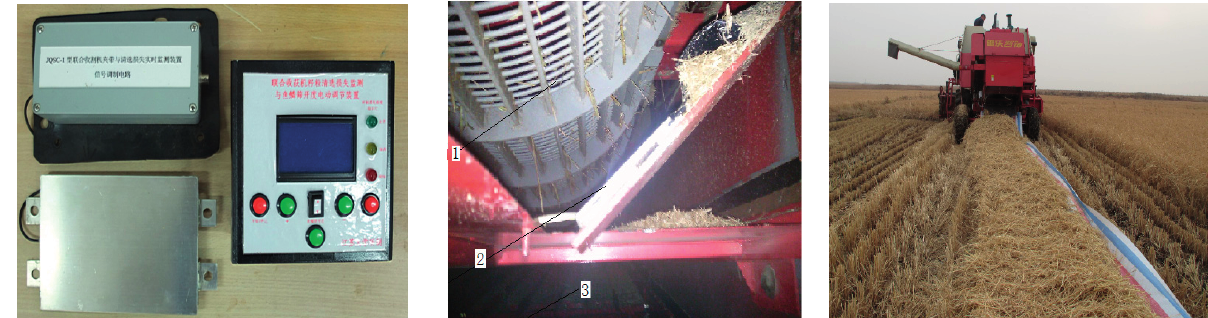
Figure 14. Installed position of the sensor on a combine harvester and experiments. 1. Separation concave; 2. Monitoring sensor; 3. Cleaning